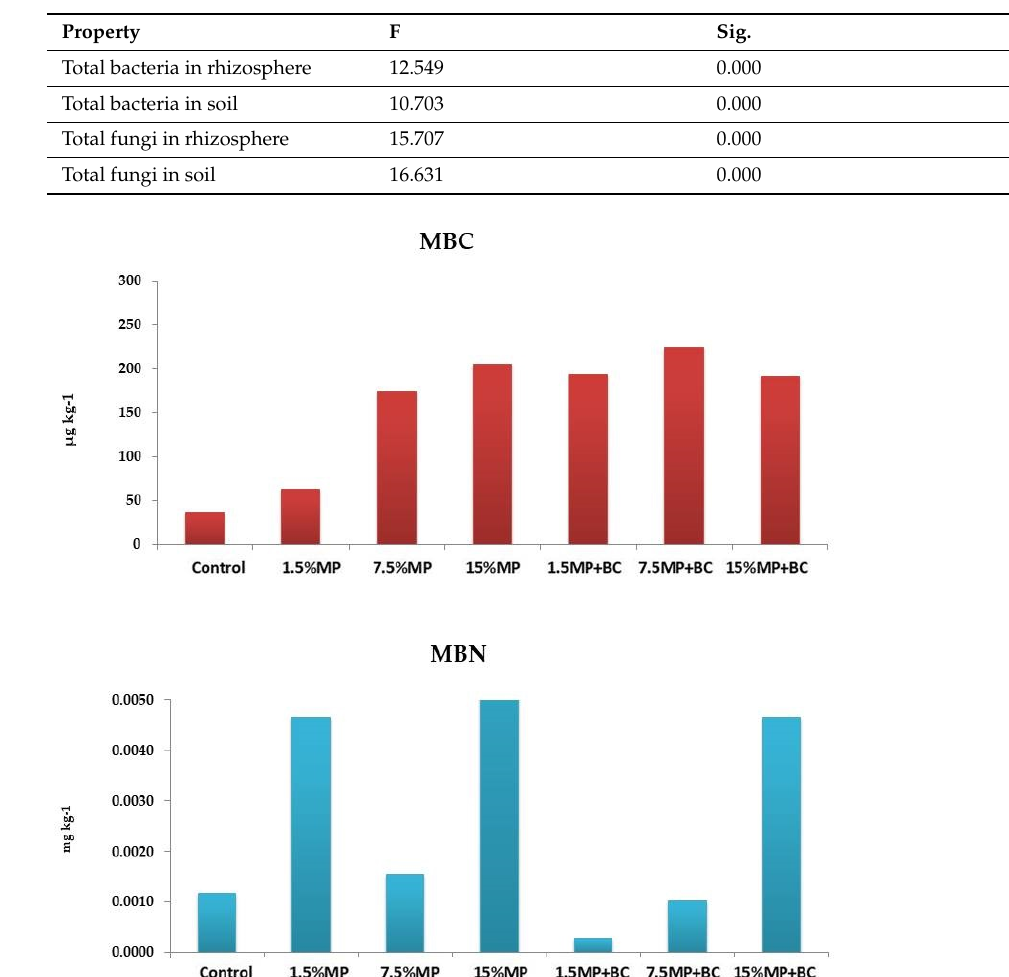
Figure 6. Biochar effects on microbial biomass C (MBC) and microbial biomass nitrogen (MBN) in soil affected by microplastic.